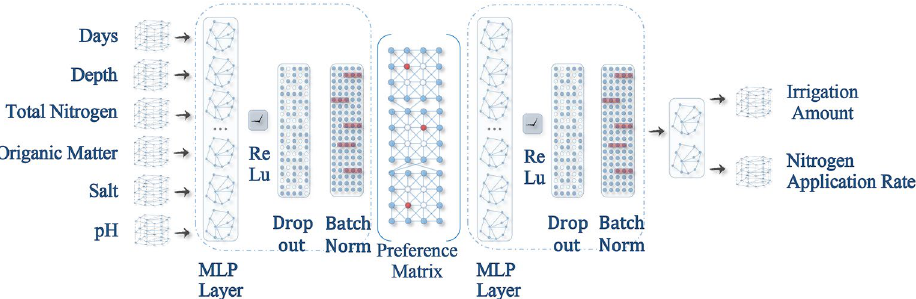
Figure 4. Schematic diagram for the PNN structural connections. In the figure, it can be seen that when each input vector passed through each layer of the PNN, it is first multiplied by the Hadamard product of the weight matrix and preference value matrix for the purpose of obtaining a weight matrix with preference properties. After the matrix was activated by the Relu Function, Batch Normalization Module Methods and the Dropout Module were used for random suspension and normalization processing, and the input of the next layer was